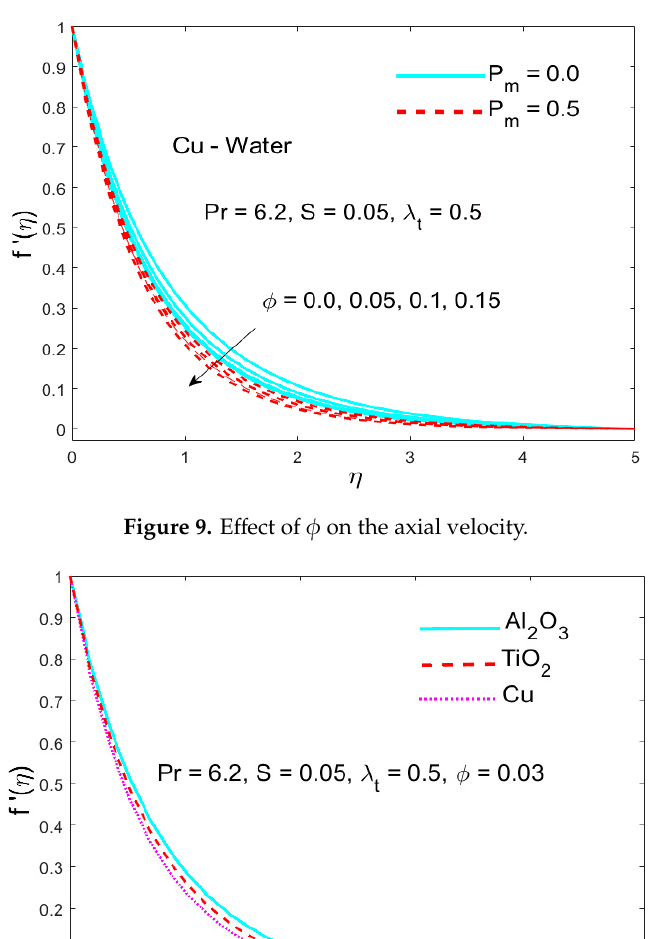
Figure 11. Variation of Cu nanoparticles on θ ( η )